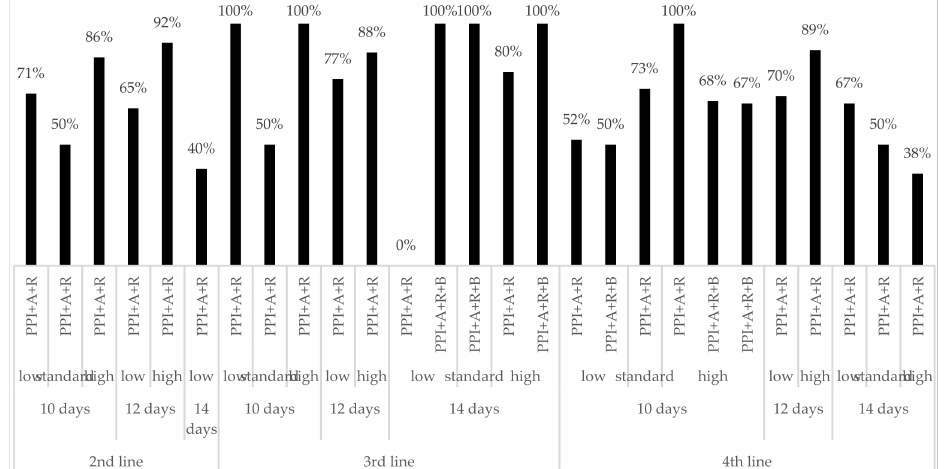
Figure 1. Effectiveness by modified intention-to-treat analysis of both triple therapy with amoxicillin and rifabutin and quadruple therapy with amoxicillin, rifabutin and bismuth, according to duration, potency of acid inhibition and treatment line. A: amoxicillin; B: bismuth; R: rifabutin; PPI: proton pump inhibitor (low-dose PPI: 4.5–27 mg omeprazole equivalents (OE) twice daily (bid) (i.e., 20 mg OE bid), standard-dose PPI: 32–40 mg omeprazole equivalents bid (i.e., 40 mg OE bid), high-dose PPI: 54–128 mg omeprazole equivalents bid (i.e., 60 mg OE